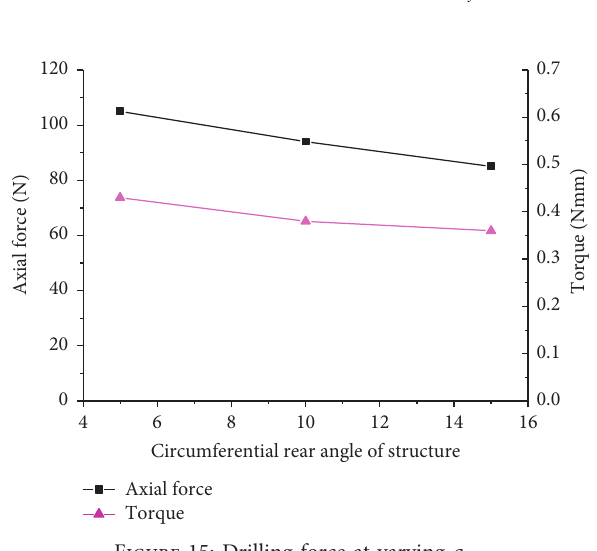
Figure 14: Tear factor Fd at varying a